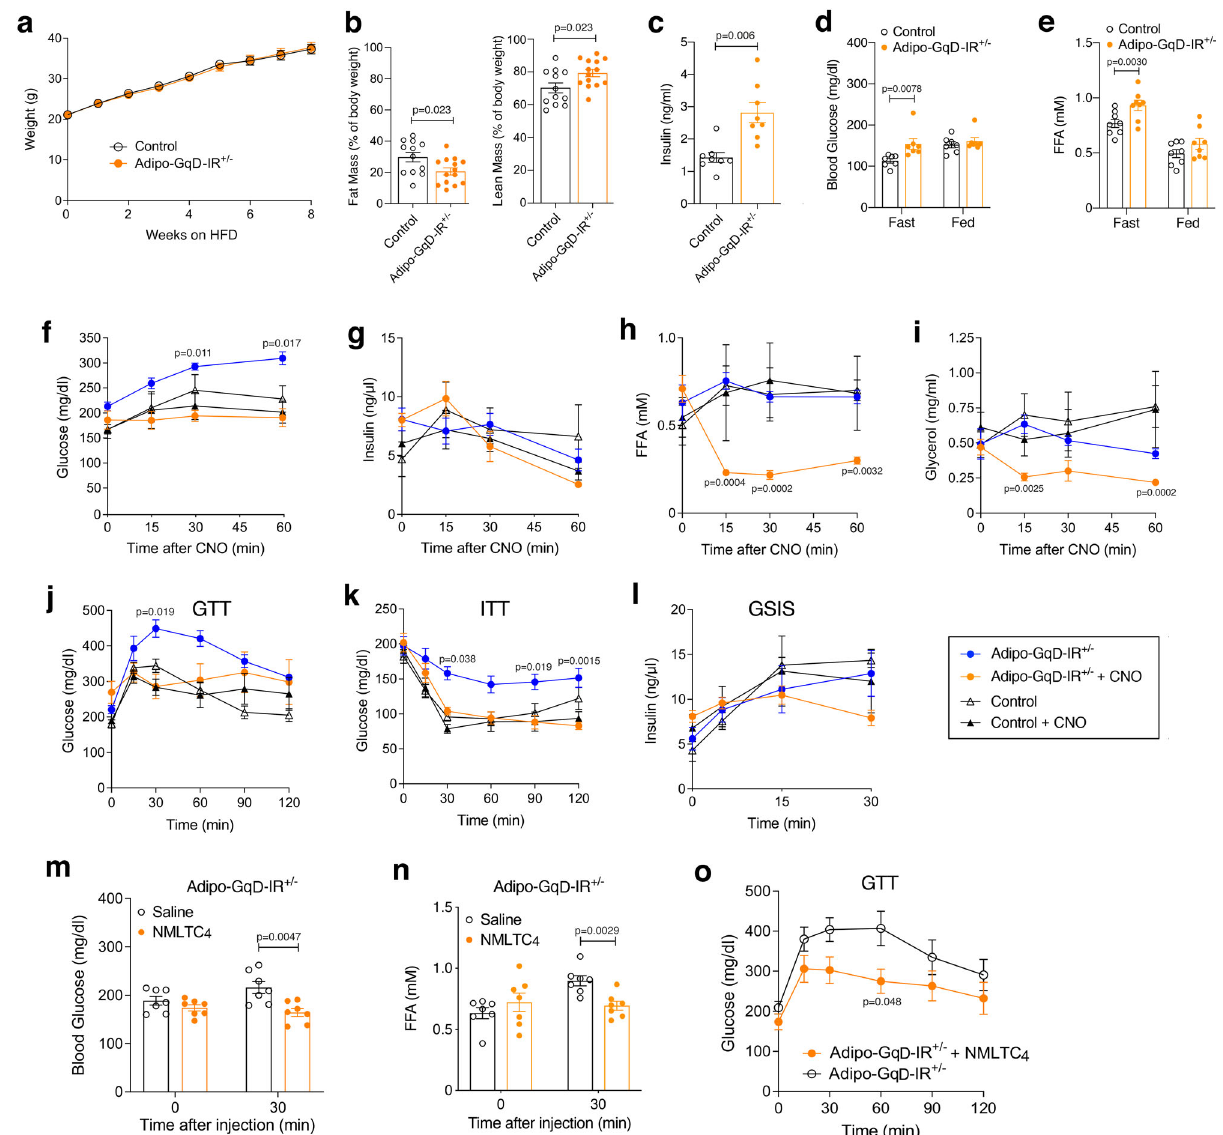
Fig. 8 Activation of adipocyte G q signaling restores normal glucose and lipid homeostasis in adipocyte-speci fi c insulin receptor (IR) mutant mice. a Body weight gain of adipo-GqD-IR + /- mice (adipocyte-speci fi c heterozygous insulin receptor knockout mice expressing GqD in adipocytes) and control littermates (LSL-GqD-IR + / fl ox mice that do not carry the adipoq-Cre transgene) maintained on a high fat diet (HFD). b – e Body composition (fat and. lean body mass) ( b ), plasma insulin levels after a 16 hr overnight fast ( c ), and fed and fasting (16 hr overnight) blood glucose ( d ) and plasma FFA levels ( e ) of adipo-GqD-IR + /- mice and control littermates maintained on HFD for ~10 weeks. f – i , Blood glucose ( f ), plasma insulin ( g ), plasma FFA ( h ), and plasma glycerol ( i ) levels of HFD adipo-GqD-IR + /- and control mice after acute treatment with CNO (10 mg/kg i.p.) following a 4 hr fast. j – l , GTT ( j ), ITT ( k ), and GSIS ( l ) performed with HFD adipo-Gq-IR + /- mice and control littermates with or without CNO (10 mg/kg i.p.) treatment. In ( j ), mice were injected with 1 g/kg glucose (i.p.) after a 4 h fast. In ( k ) and ( l ), mice that had been fasted for 4 hr received 1 U/kg insulin (i.p) or a bolus of glucose (1 g/kg i.p.), respectively. m – o , NMLTC 4 treatment of HFD adipo-GqD-IR + /- mice. m , n , Blood glucose ( m ) and plasma FFA ( n ) levels of HFD adipo-GqD-IR + /- mice after treatment with NMLTC 4 (10 μ g/kg) or saline following a 4 h fast. o , GTT. After a 4 h fast, HFD adipo-GqD-IR + /- mice were injected with glucose (1 g/ kg i.p.), either in the presence or absence of NMLTC 4 (10 μ g/kg). All experiments were carried out with male mice maintained on HFD for 8 – 14 weeks Data are presented means ± s.e.m. ( a , b : n = 10-14 per group; c – o : n = 5-8 per group). b – e , m , n : two-tailed Student ’ s t -test; f – l , o : two-way ANOVA followed